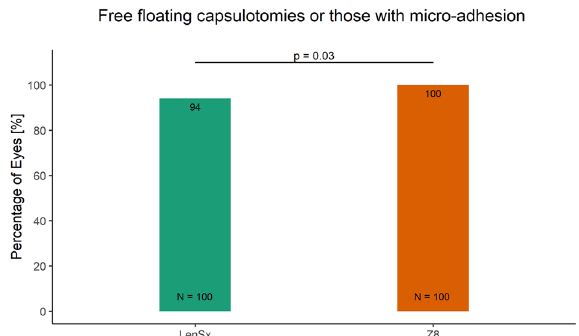
Figure 1. The proportion of eyes with free-floating capsulotomies or those with micro adhesions in the LenSx and the Z8 laser